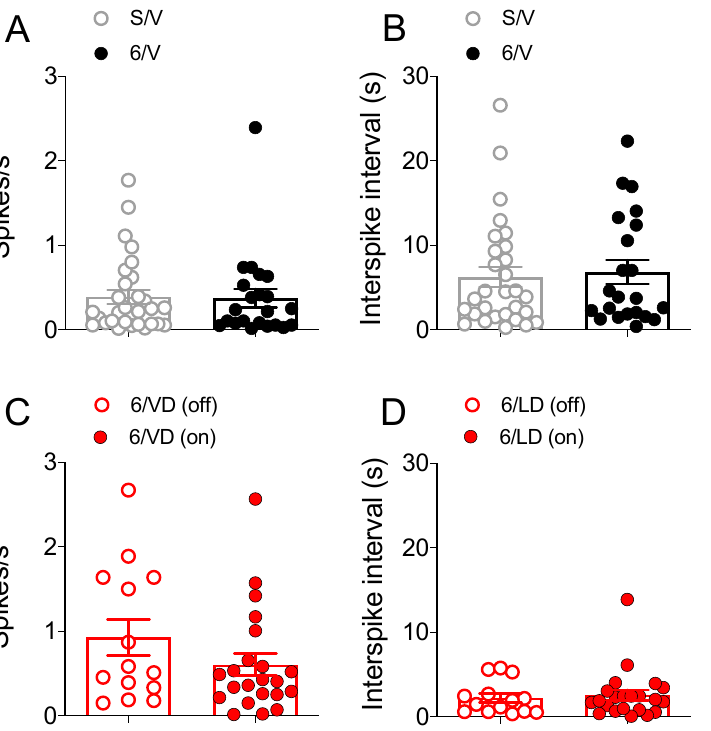
Figure 5. Group comparisons of the 6 ‐ OHDA lesion and L ‐ DOPA treatment on spontaneous activity recorded from spontaneously active unidentified striatal MSNs. There was no difference in the ( A ) firing rate and ( B ) interspike interval in MSNs recorded in the striatum of sham ‐ operated and 6 ‐ OHDA ‐ lesioned rats ( p > 0.05, t ‐ test). There was no difference between ( C ) firing rates or ( D ) interspike interval in MSNs recorded in the striatum of dyskinetic rats before (off) and after (on) L ‐ DOPA administration ( p > 0.05, t ‐ test). Data are presented as the mean ± SEM. Results are derived from n = 14/29 animals/cells in the S/V group, n = 10/22 animals/cells in the 6/V group, and 13/14–22 animals/cells in the 6/LD group.